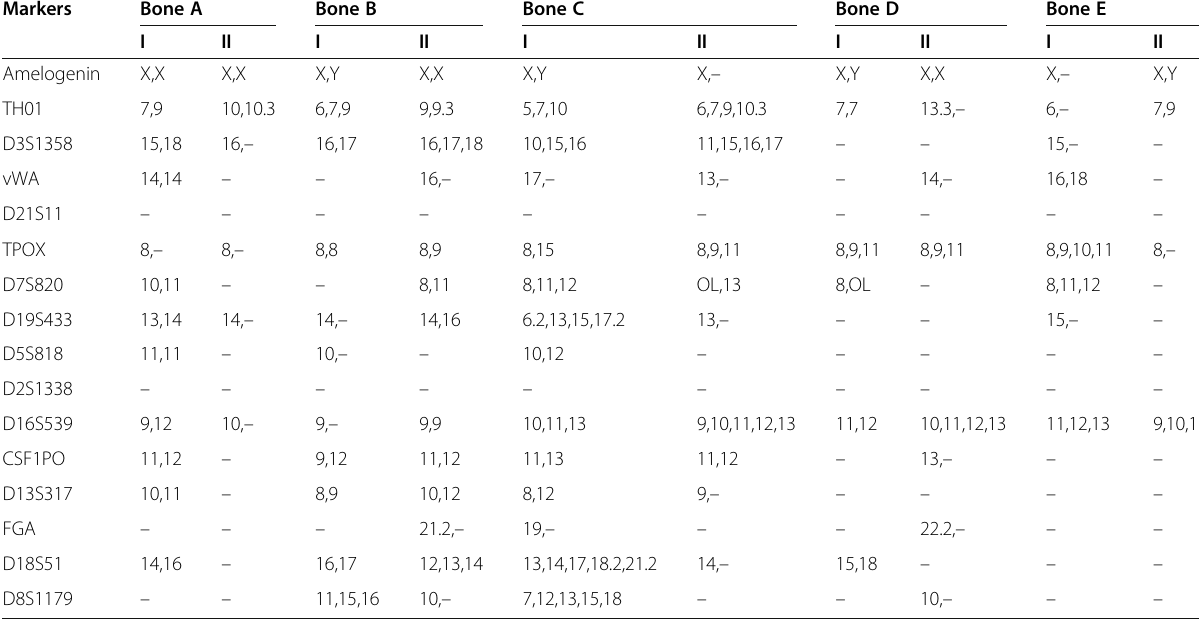
Table 5 Comparison of the detected allele in STR profiles between different five bone samples processed with/without prior total demineralization process using the QIAGEN Investigator® IDplex Plus Kit Markers Bone A Bone B Bone